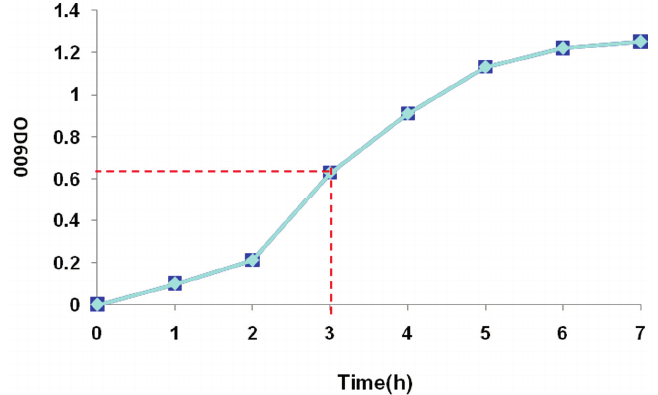
Figure 3. Growth curve of pET32a (+) S-Apyrase/BL 21(DE3). OD600 reached 0.6 at 3 h.